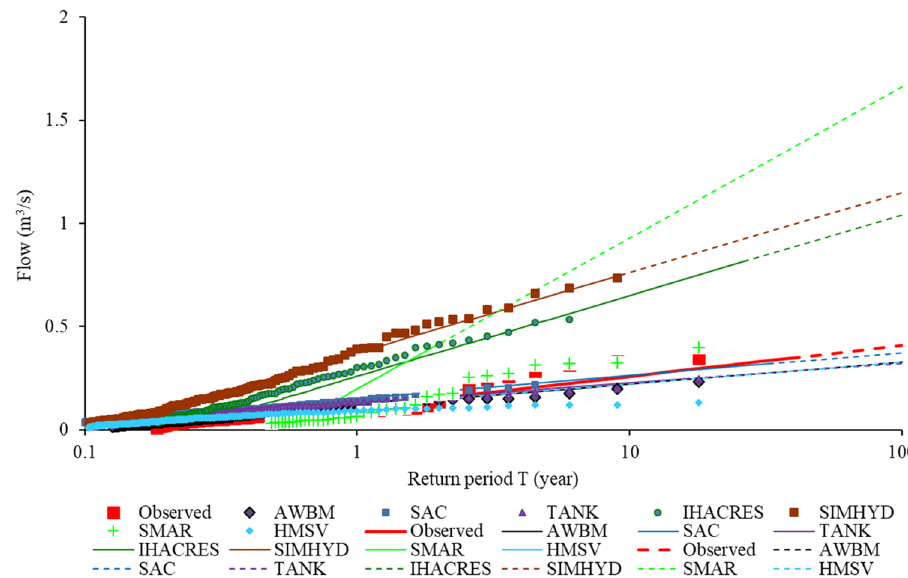
Fig. 11 Comparison of expo- nential quantile–quantile plot for the low flow POT events considering 1-day aggregation level. The markers represent the empirical, solid lines signify theoretical (calibrated distribu- tion), while dashed lines repre- sent extrapolated